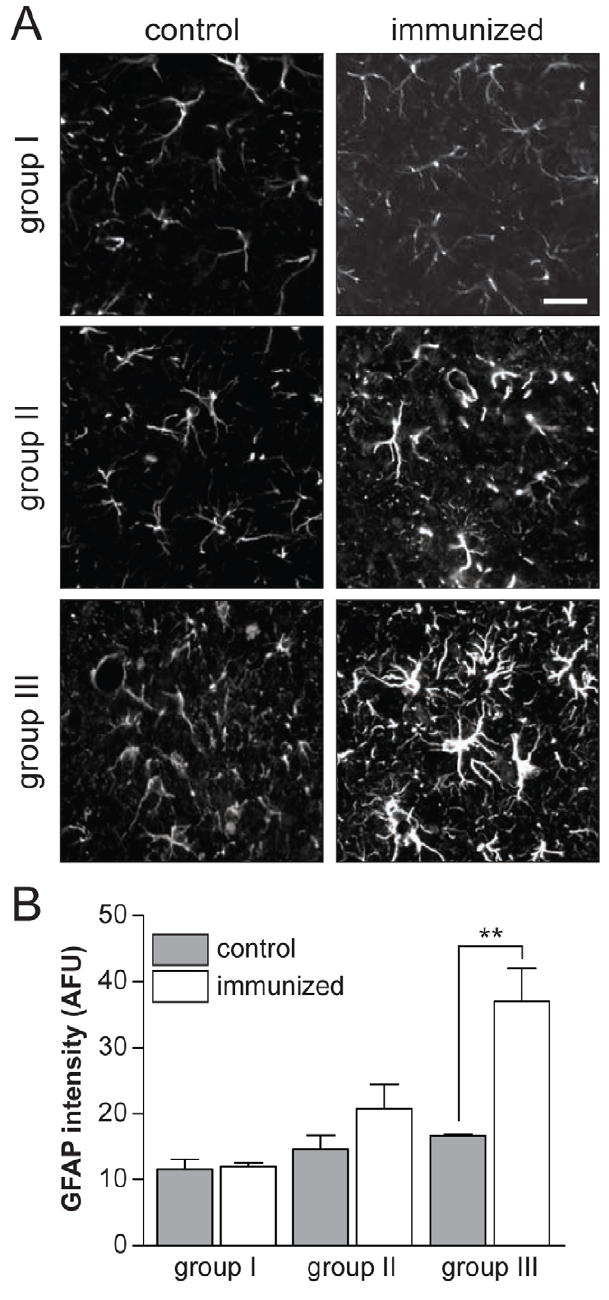
Figure 4. Tau-targeted immunization results in astrocytosis in old, but not young pR5 mice. ( A ) Immunohistochemistry with a GFAP-specific antibody stains astrocytes in brains of control and immunized 14 (group I), 17 (group II) and 24 (group III) months-old pR5 mice. Representative images of amygdalae show similar low GFAP staining of astrocytes in controls for all three groups, consistent with absence of an overt astrocytosis even in aged pR5 mice. In 14 months- old immunized pR5 mice (group I), GFAP staining is comparable to controls, while astrocytes stain more intensive in 17 months-old immunized pR5 (group II). In 24 months-old immunized mice (group III), GFAP staining is much stronger than in controls, and numerous astrocytes have adopted a tufted morphology, suggesting activation. Scale bar, 25 m m. ( B ) Quantification of GFAP staining intensity in the amygdala on serial sections of control and immunized pR5 mice revels a significant 2.2-fold increase in 24 months-old pR5 mice of group III compared to non-immunized pR5 controls ( p , 0.0001,